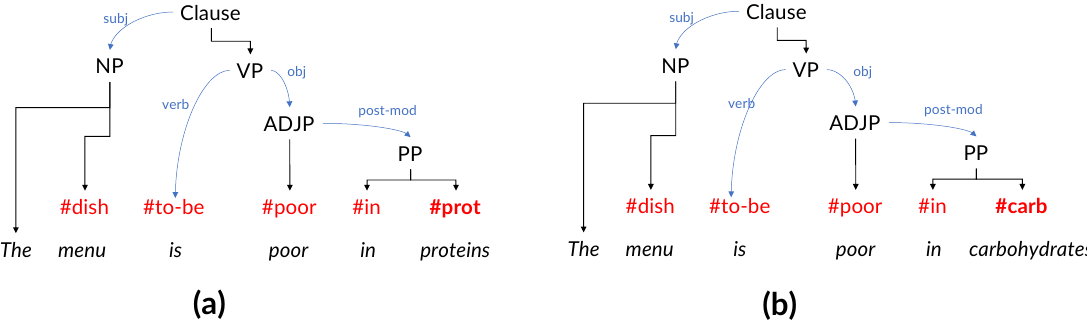
Figure 5. Two quasi-trees corresponding to specific messages on ( a ) proteins and ( b ) carbohydrates and the corresponding realized sentences.